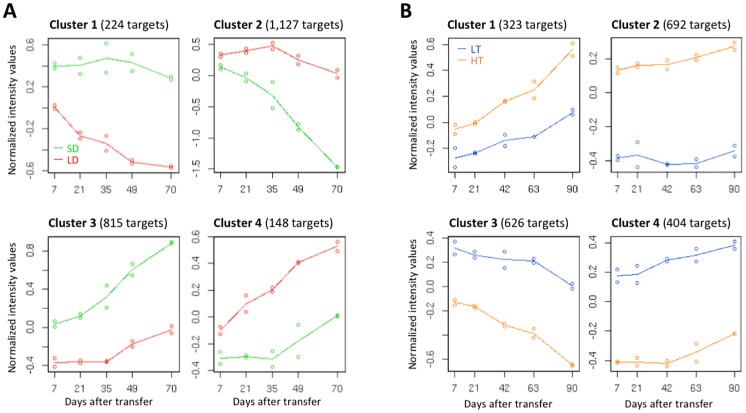
Expression pattern of a cluster of targets regulated by day length and temperature.(A) Median profile of four clusters of SD-regulated targets under LD and SD conditions (red and green, respectively). (B) Median profile of four clusters of LT-regulated targets under HT and LT conditions (orange and blue, respectively).